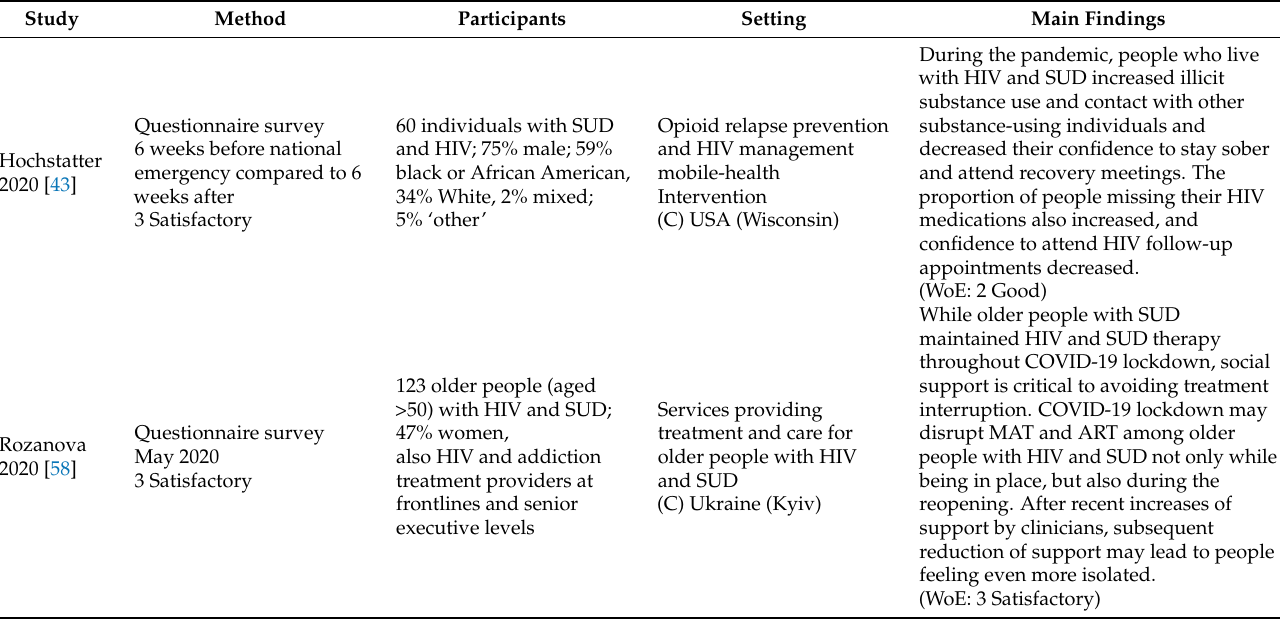
Table 9. People with HIV and Substance Use Disorder.